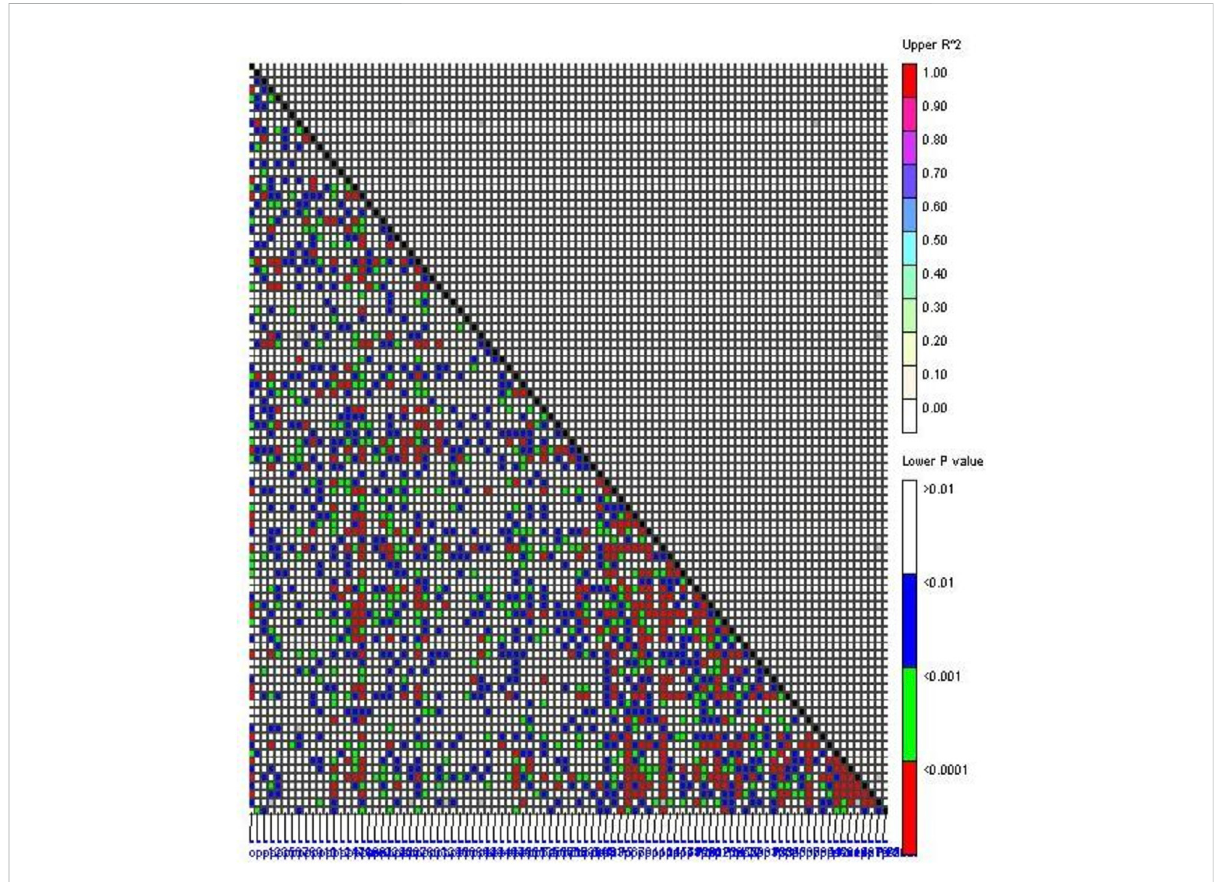
FIGURE 4 Linkage disequilibrium between marker pairs. The lower diagonal part represents p -values between the marker pairs; the upper diagonal part represents the R 2 value between marker